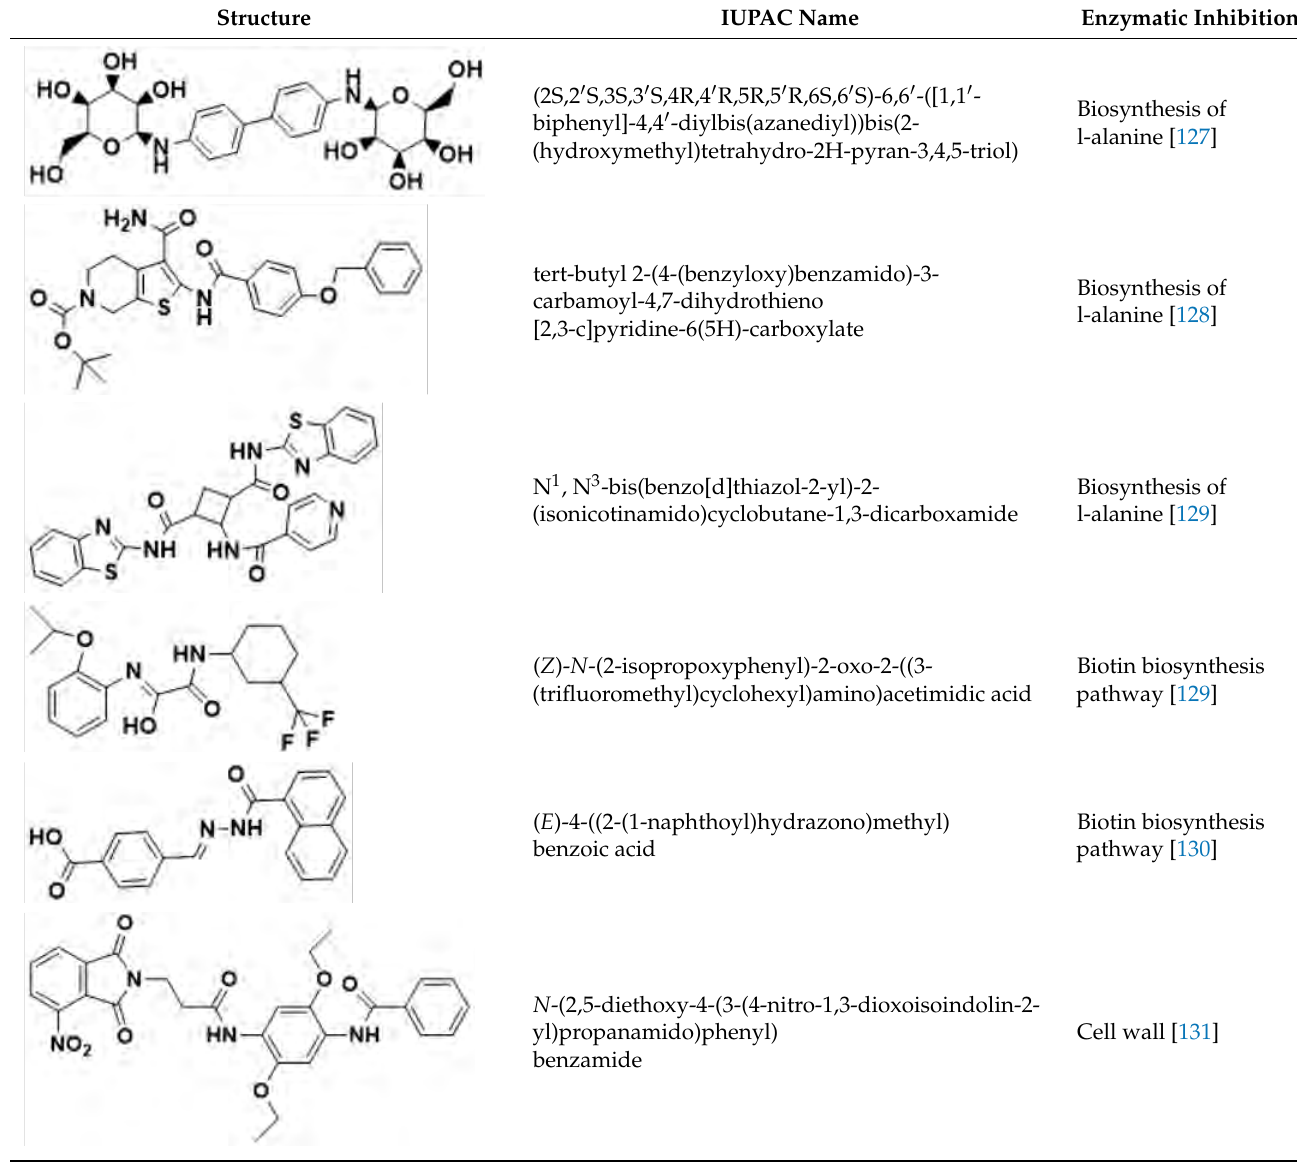
Table 5. Structure of identified molecules with the best anti-Mtb activity or enzymatic